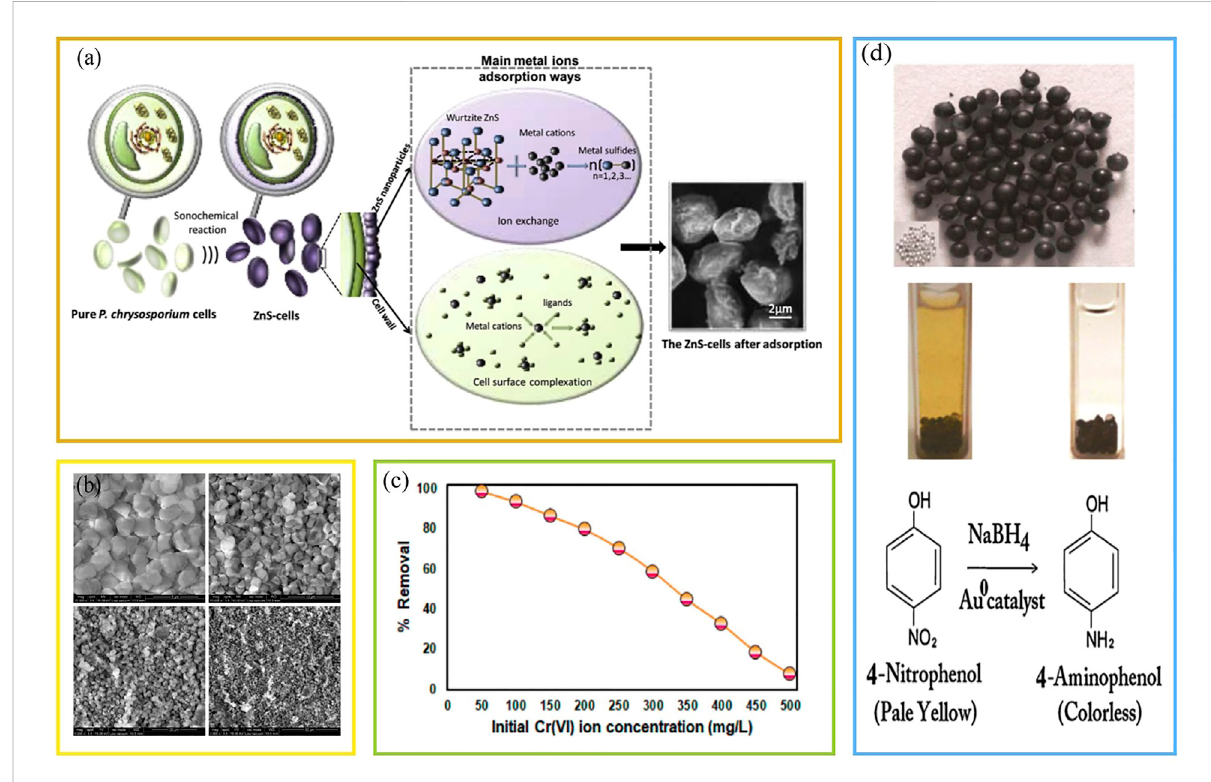
FIGURE 4 (A) High-performance adsorption of Pb 2+ and Cd 2+ by ZnS nanoparticle layer (Qin et al., 2020), (B) synthesis of magnetic nanoparticles coated mixed fungal biomass (MNP-FB), (C) adsorption of Cr(VI) ions (Saravanan et al., 2021), (D) nanocomposite biomass synthesis of materials and